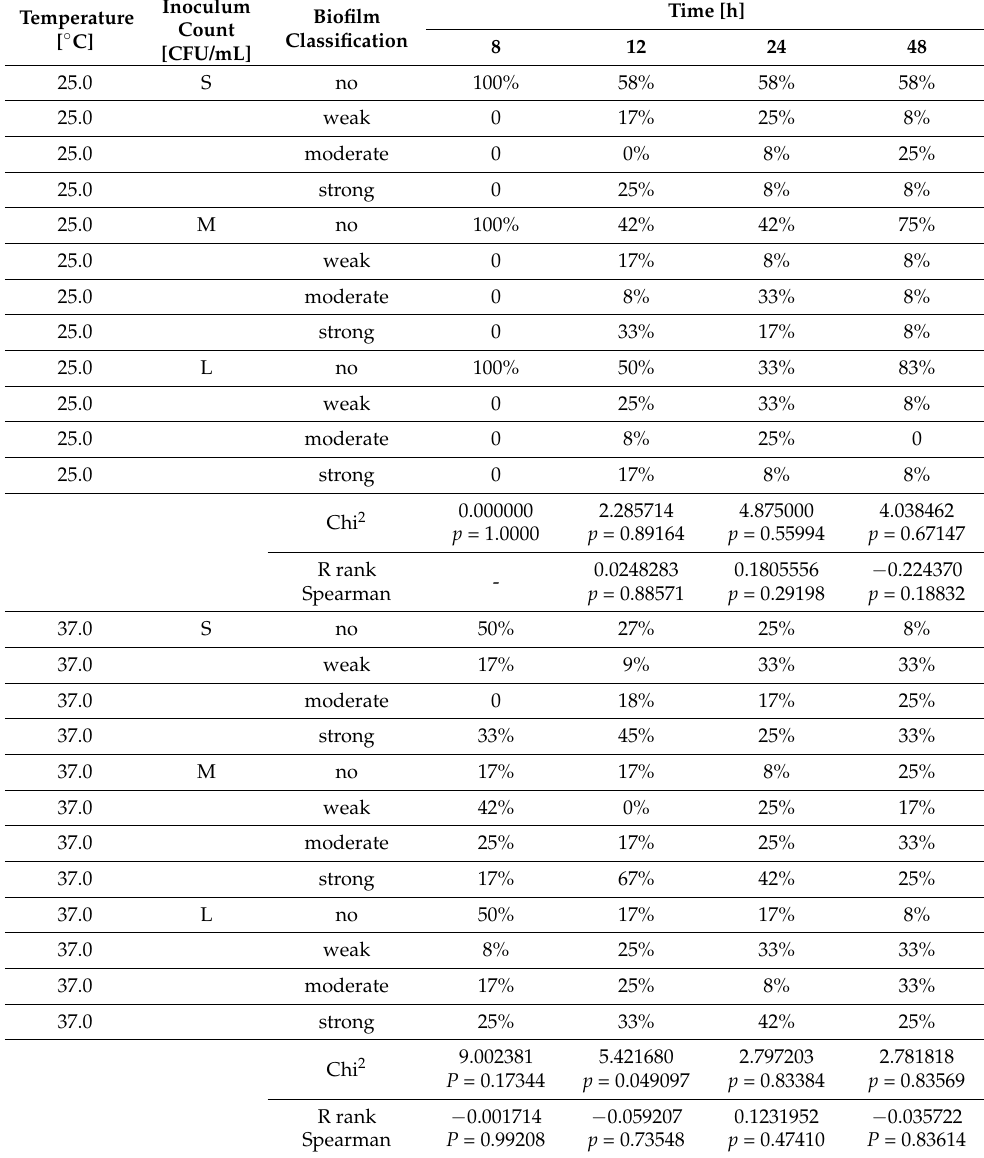
Table 2. Quantitative biofilm formation by tested bacterial isolates and C. sakazakii [%], dependent on incubation time and inoculum